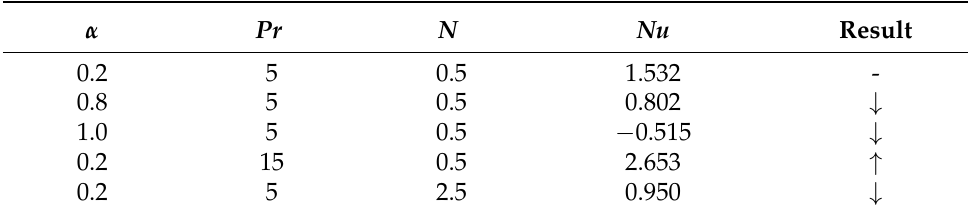
Table 1. Nusselt number with various values of parameters.